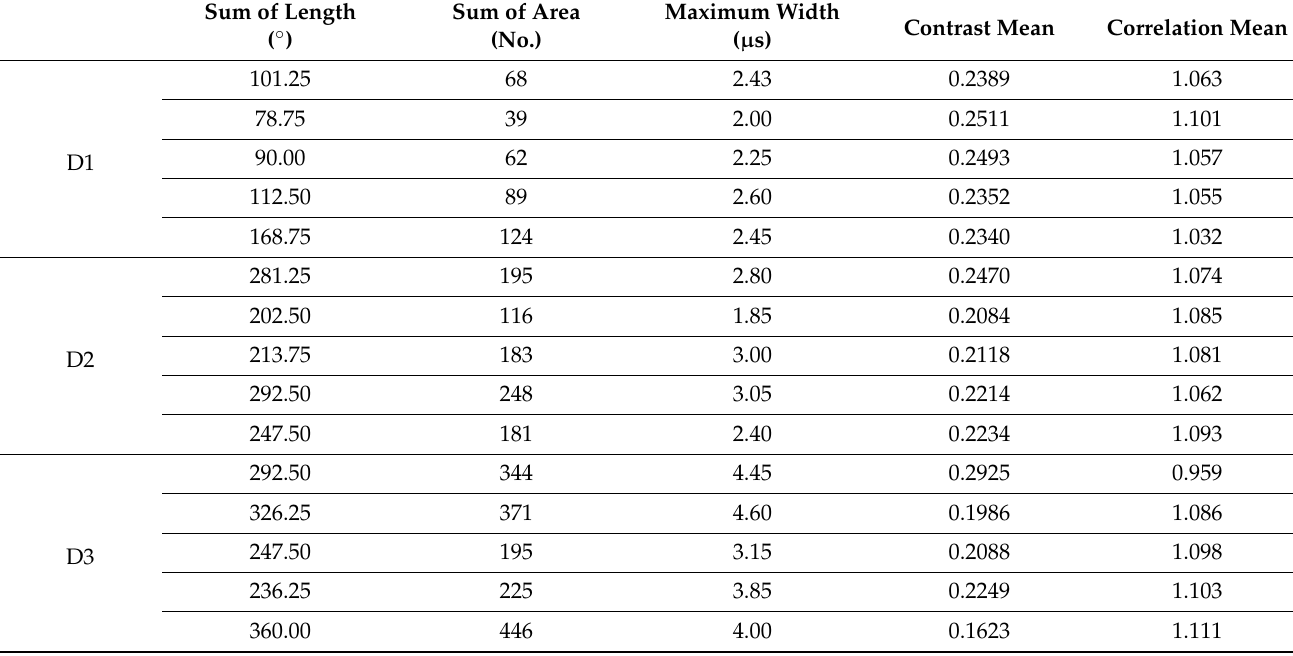
Table 6. Features of some defect